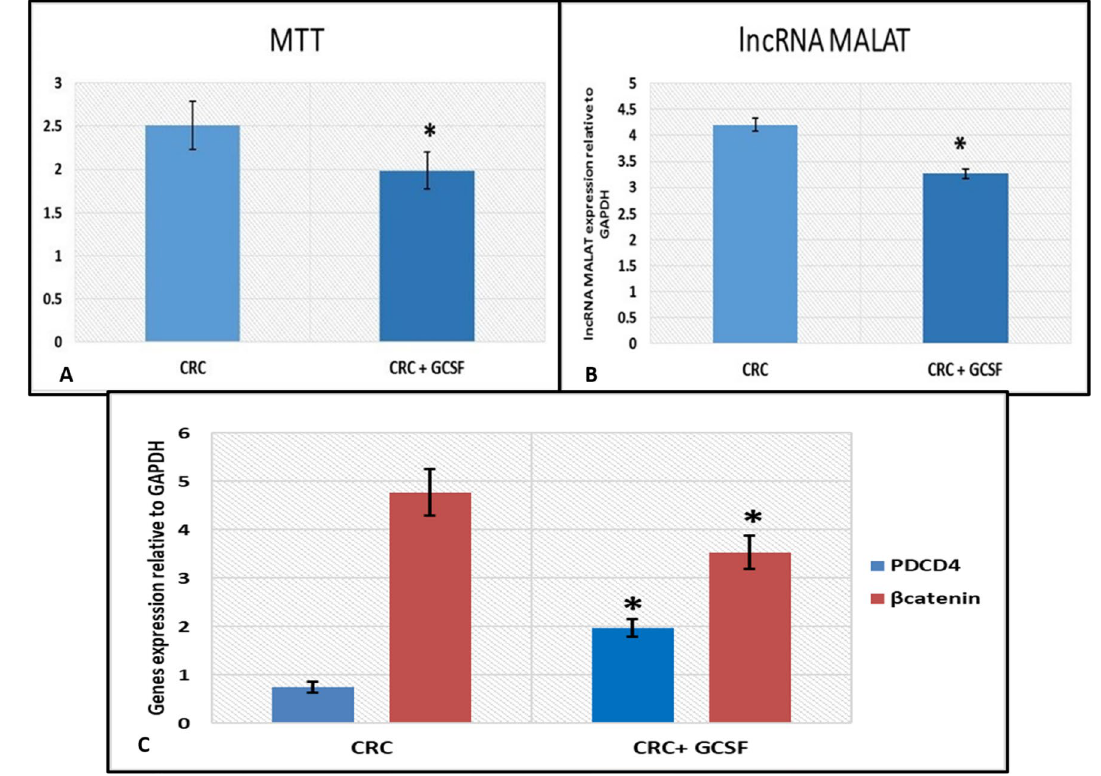
Fig. 2 A MTT assay of both studied groups. B comparison of LncRNA MALAT expression between CRC studied groups. C comparison of PDCD4 and β catenin genes expression between CRC studied groups (*) Denotes significant difference compared to untreated CRC cells